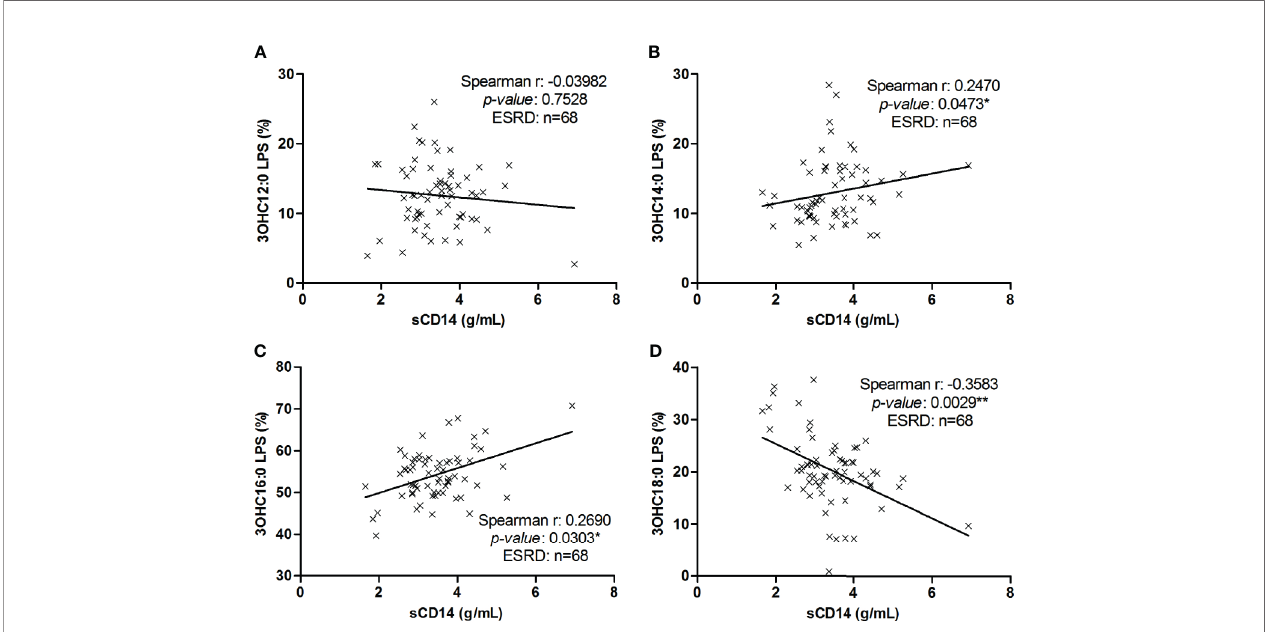
FIGURE 4 | Correlation between LPS subtype ’ s proportion with sCD14 in end-stage renal disease (ESRD) patients. Correlation between sCD14 serum levels and 3OHC12:0 (A) , 3OHC14:0 (B) , 3OHC16:0 (C) or 3OHC18:0 (D) LPS proportions in ESRD patients (n = 68). Each cross represents a patient. Linear regression was displayed on graphs. Spearman correlation between sCD14 and LPS proportions, * p < 0.05, ** p < 0.01. LPS, lipopolysaccharide; sCD14, soluble cluster of differentiation